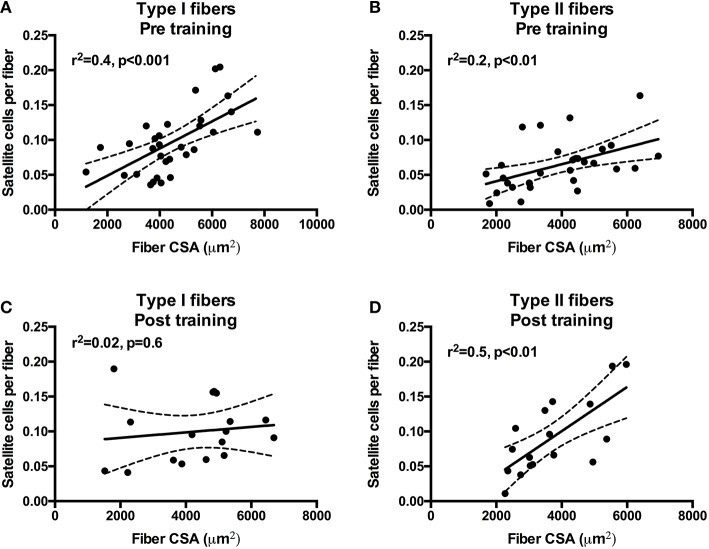
Correlations and scatter plots of type I and type II fiber cross-sectional area (CSA) and satellite cell content at pre-training (A,B) and post-training (C,D). Dashed lines denote the 95% confidence intervals. Pearson correlation coefficients (r2) and significance are shown for each correlation.